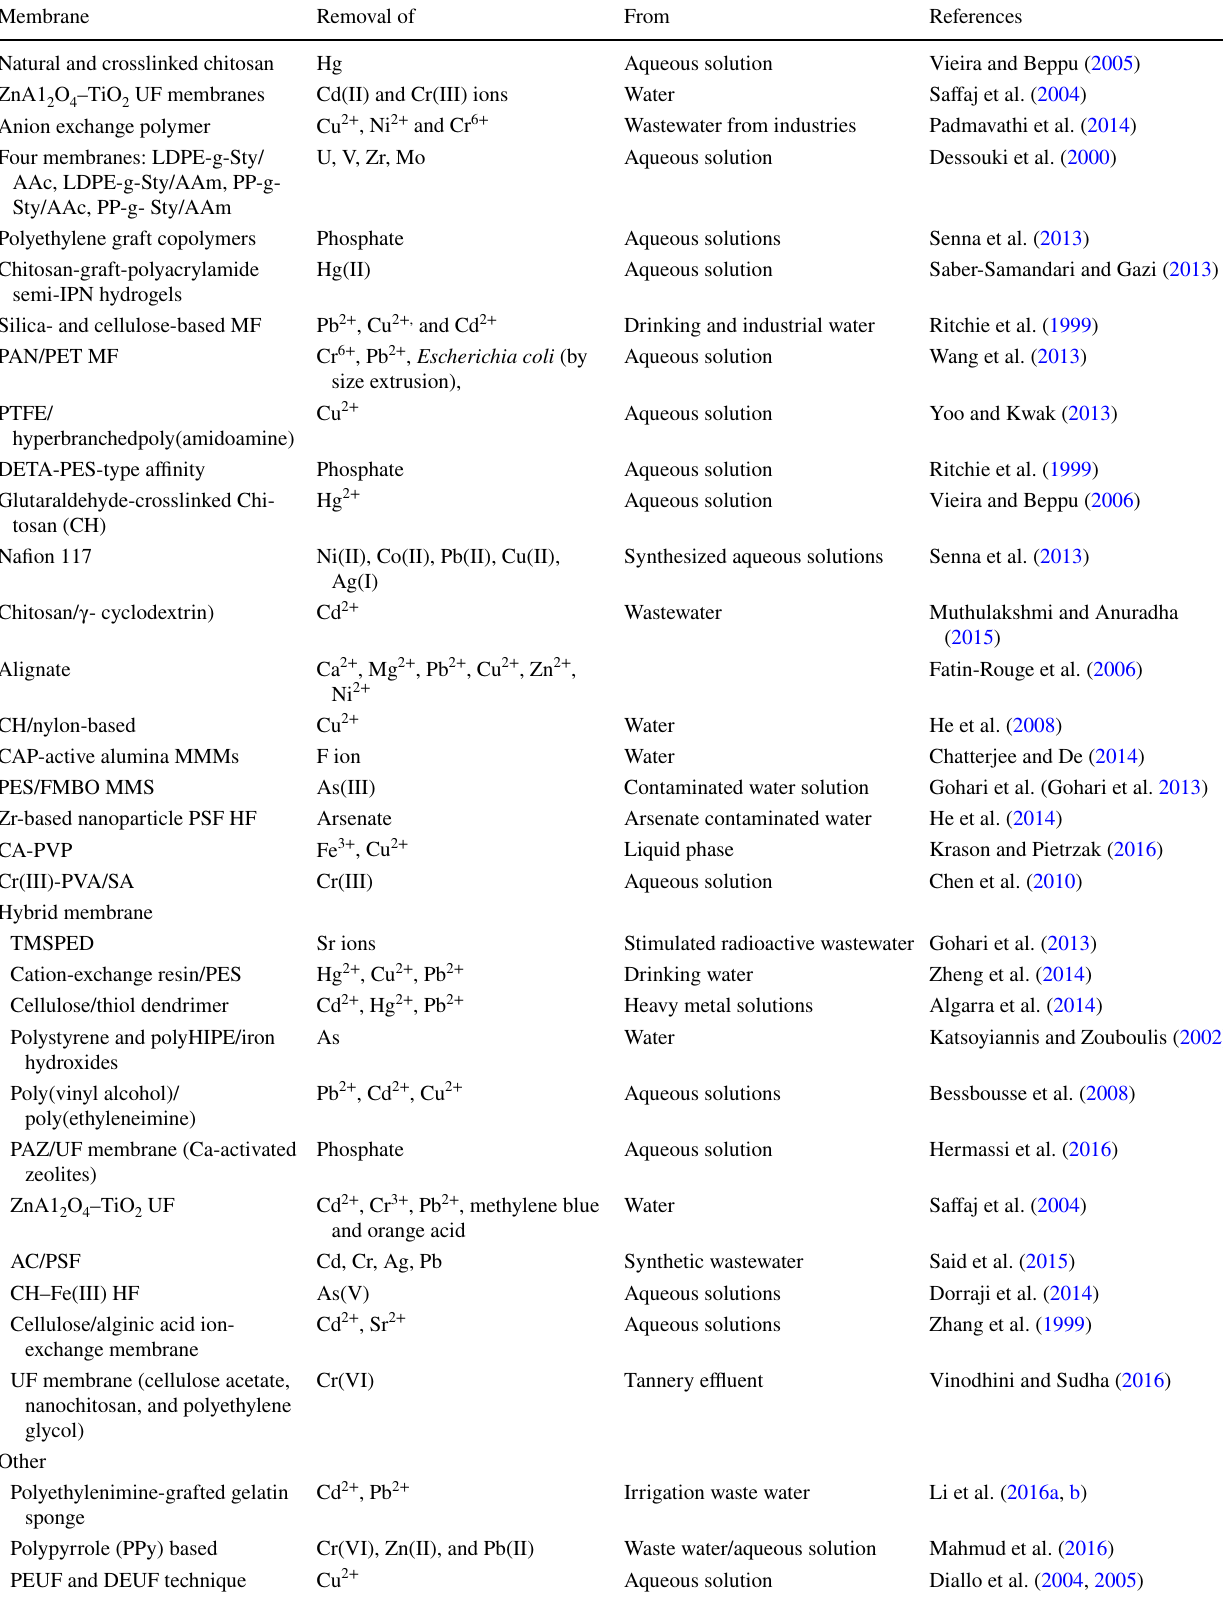
Table 3 Summary of the removal of heavy metals/pollutant from water/wastewater by